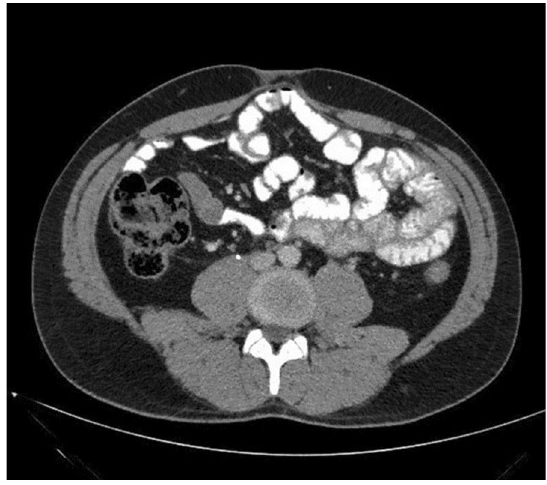
Fig. 5 Abdominal contrast-enhanced CT 2 years after the operation showing no residual